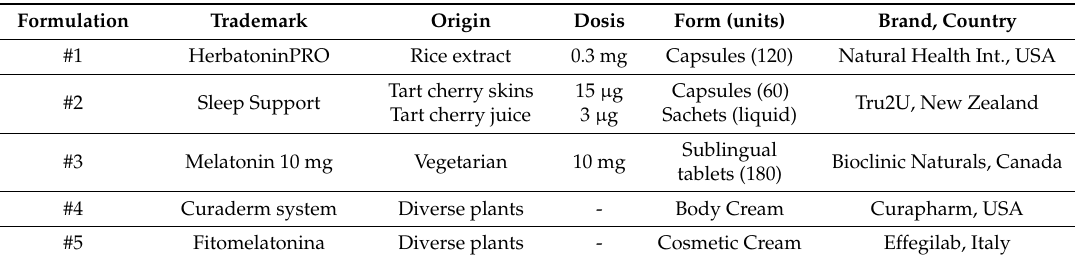
Table 5. Different commercial formulations containing